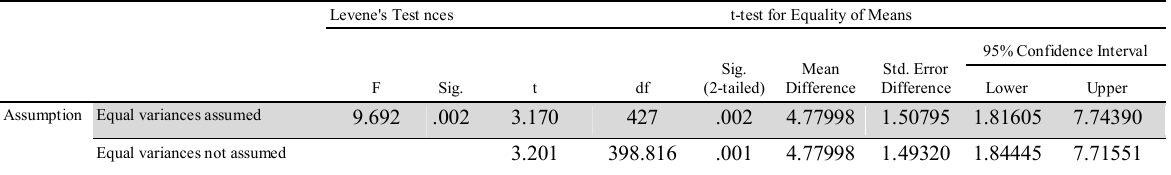
The summary of testing the effect of gender Levene's Test nces t-test for Equality of Means F